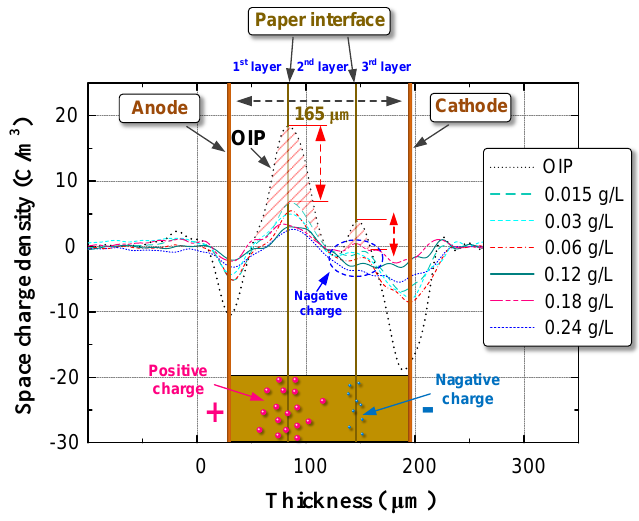
Figure 9. Space charge distribution in OIP and NOIP.